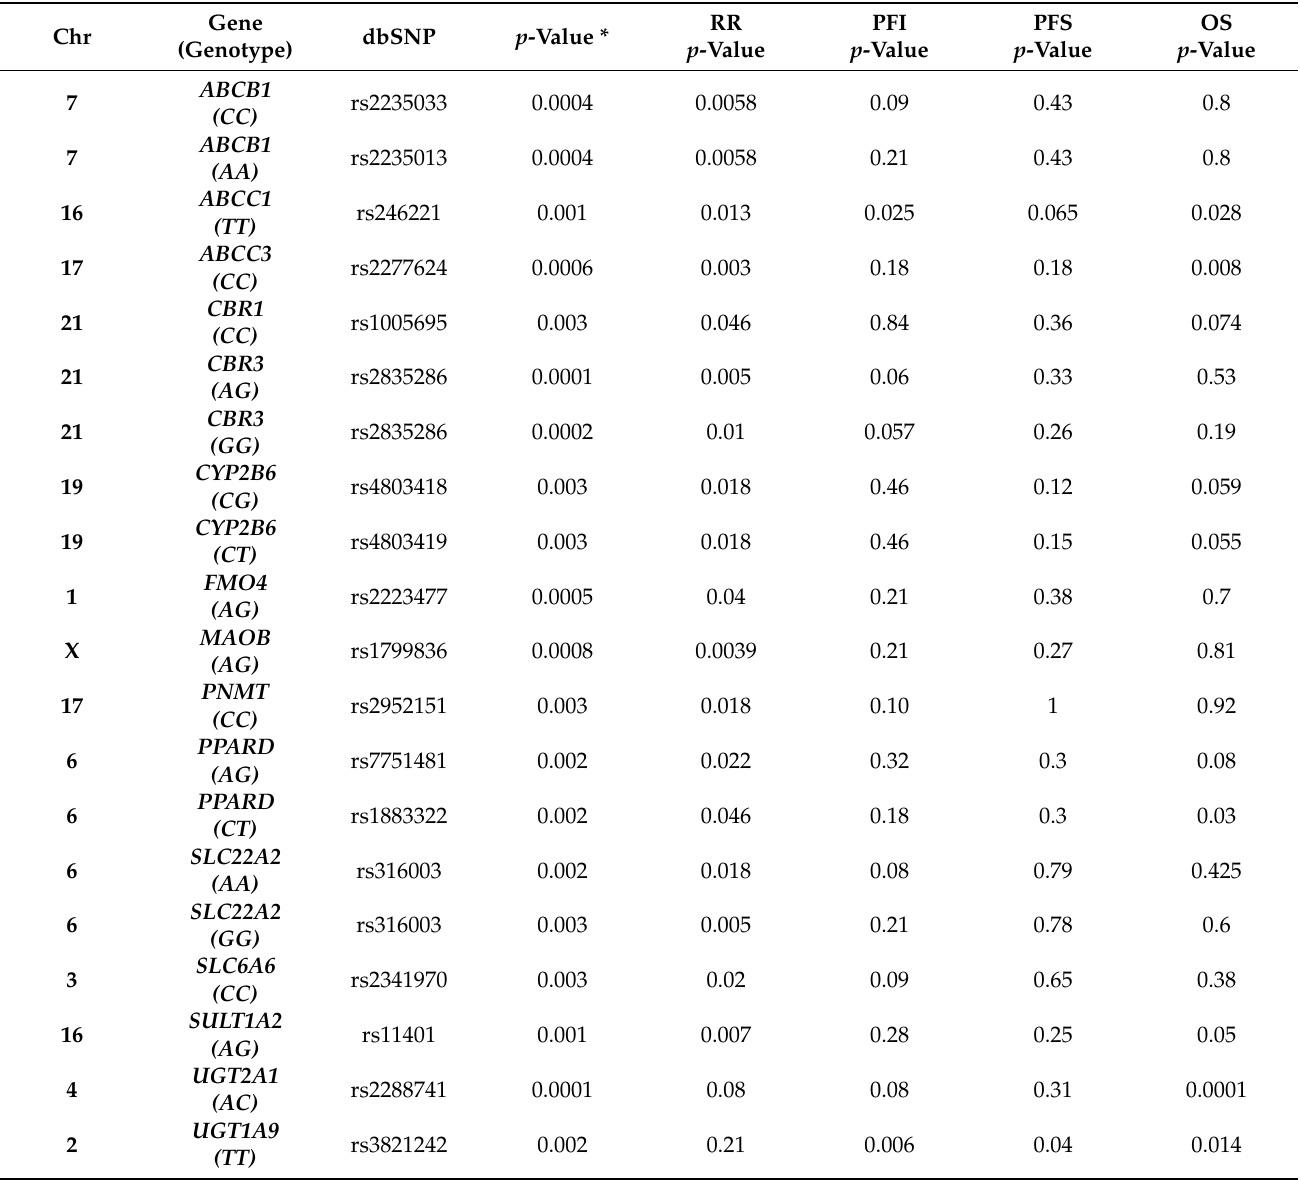
Table 4. DMET analysis (Summary of results). Genotypes of 20 SNPs in ADME genes and the association with platinum-based response and OS in patients with